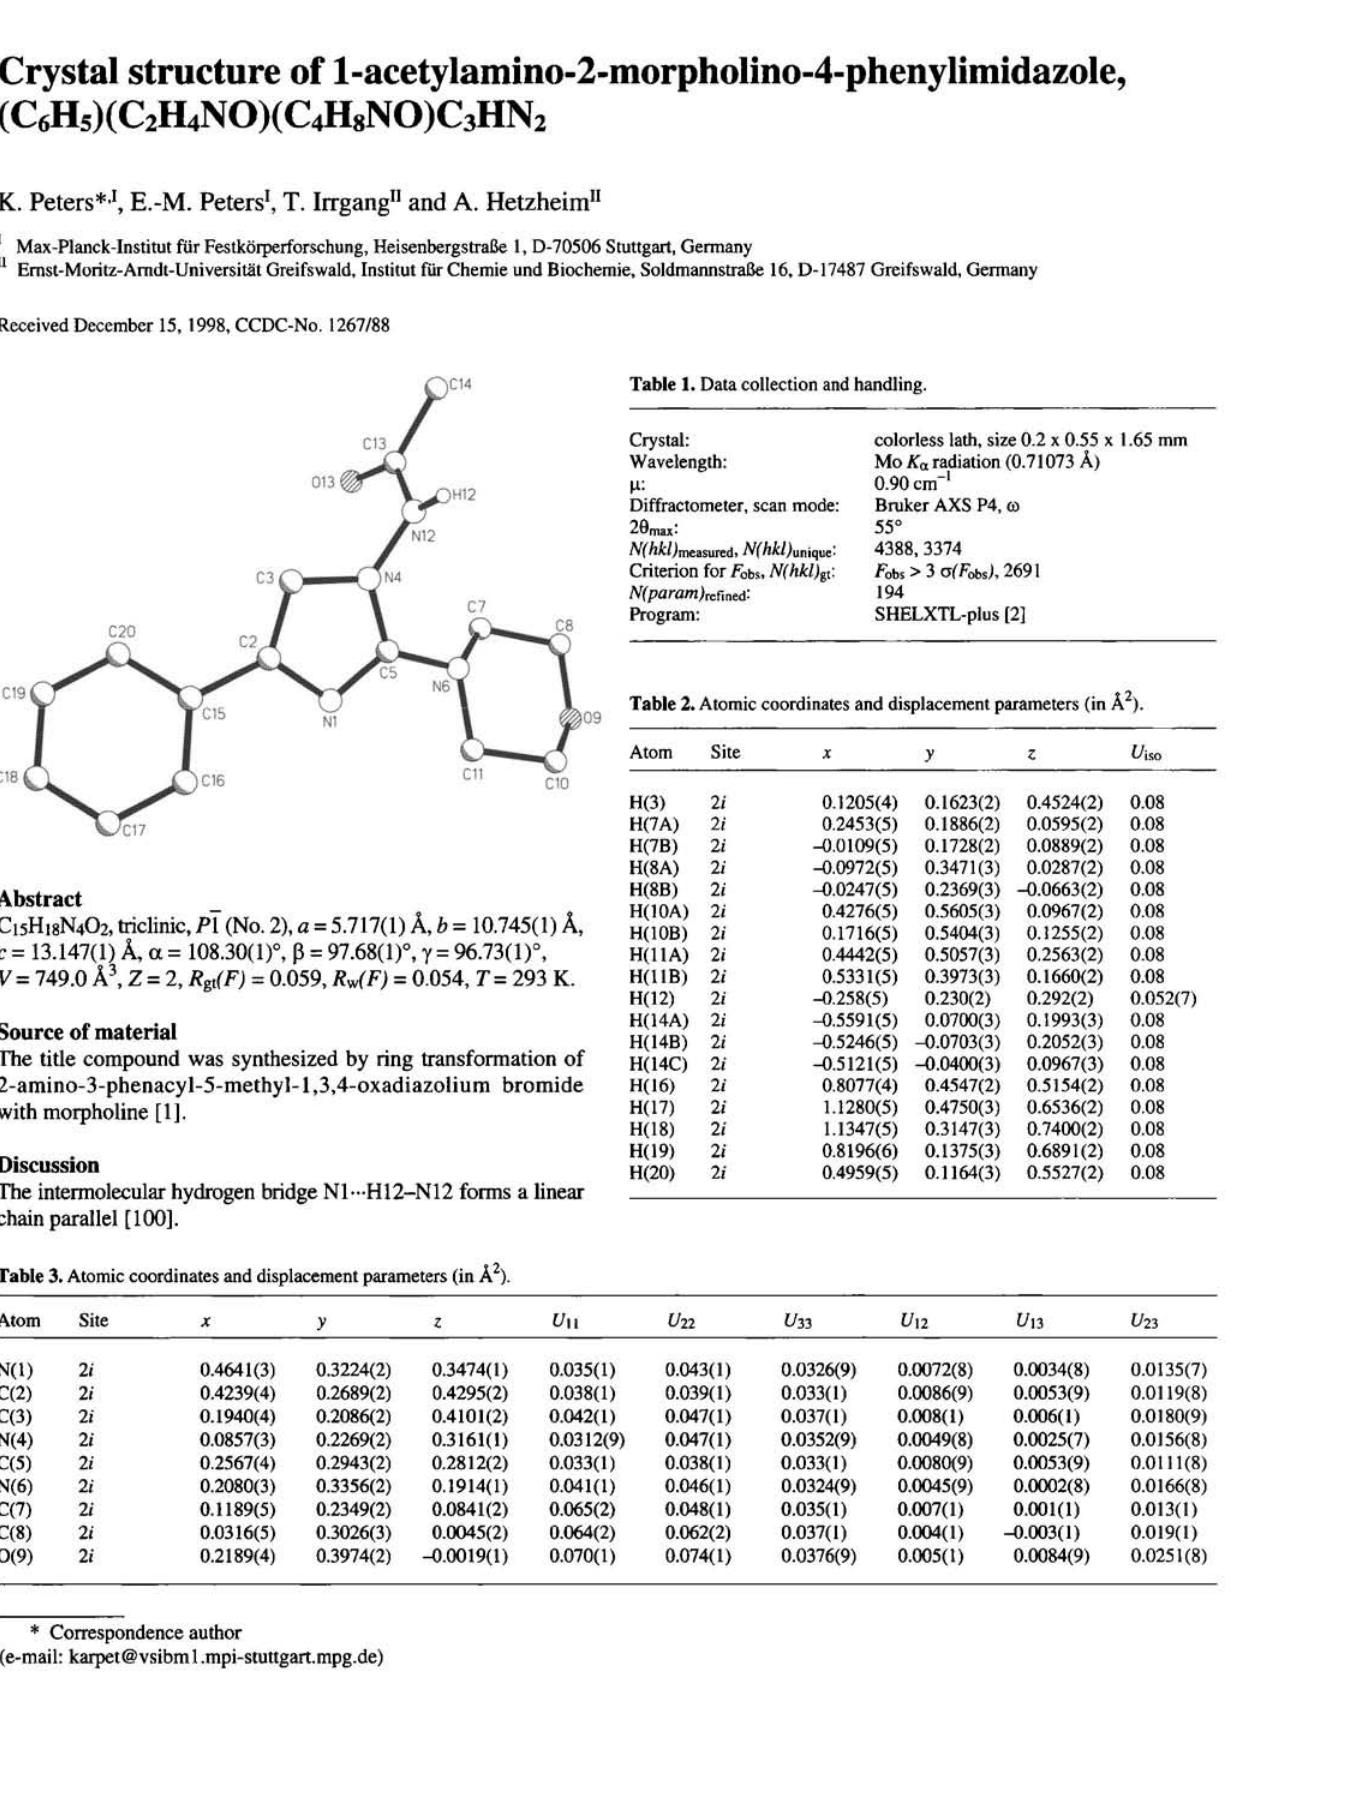
Table 3. Atomic coordinates and displacement parameters (in Â 2